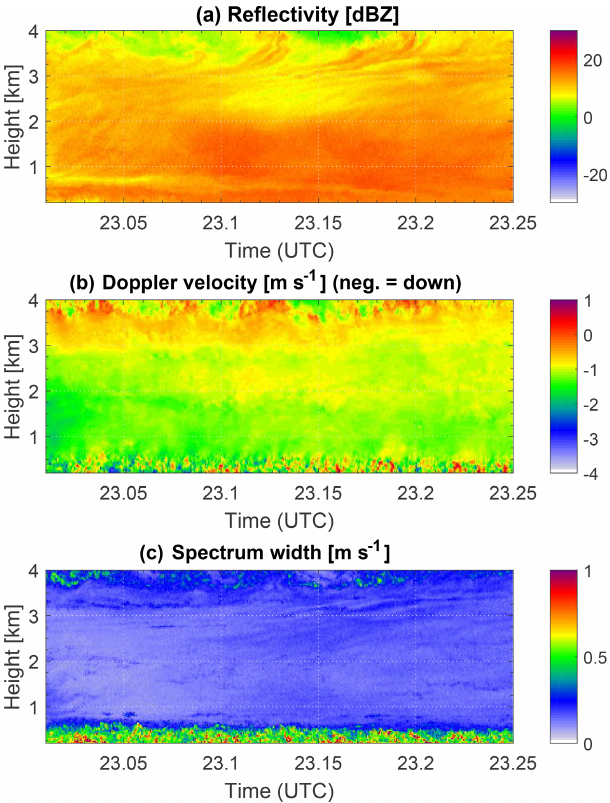
Figure B1. Like Fig. 4 but for 21 February 2014, 23.01–23.25UTC, at 0.2–4km height.